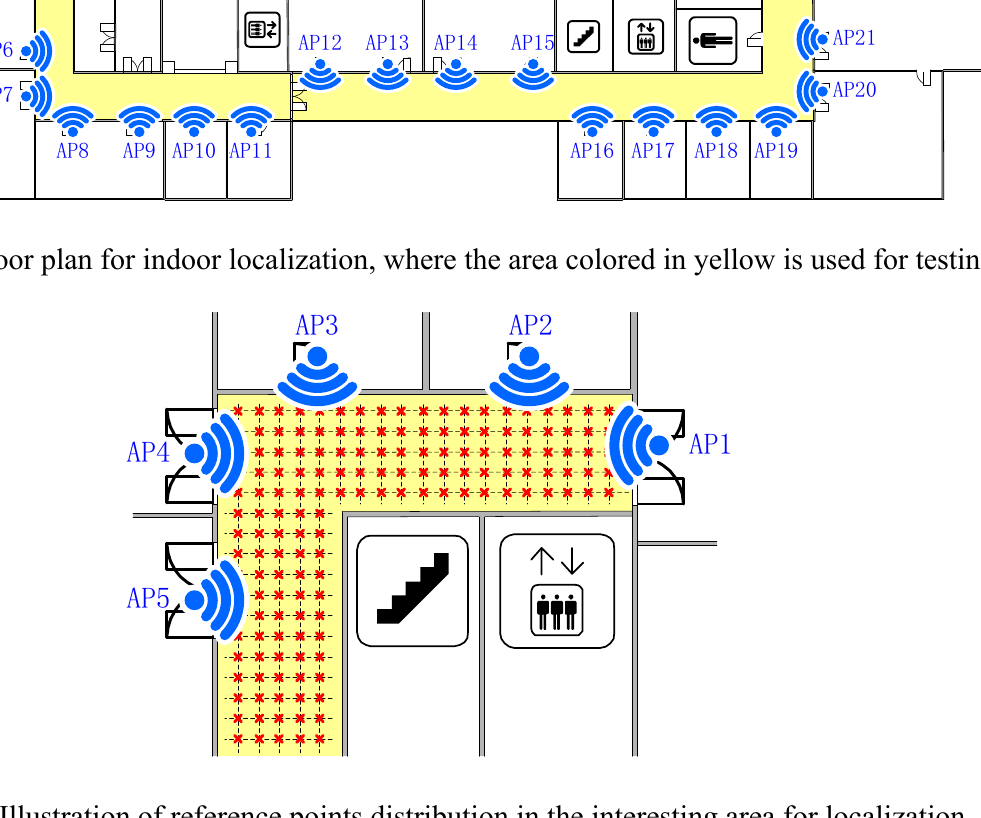
Figure 8. Illustration of reference points distribution in the interesting area for